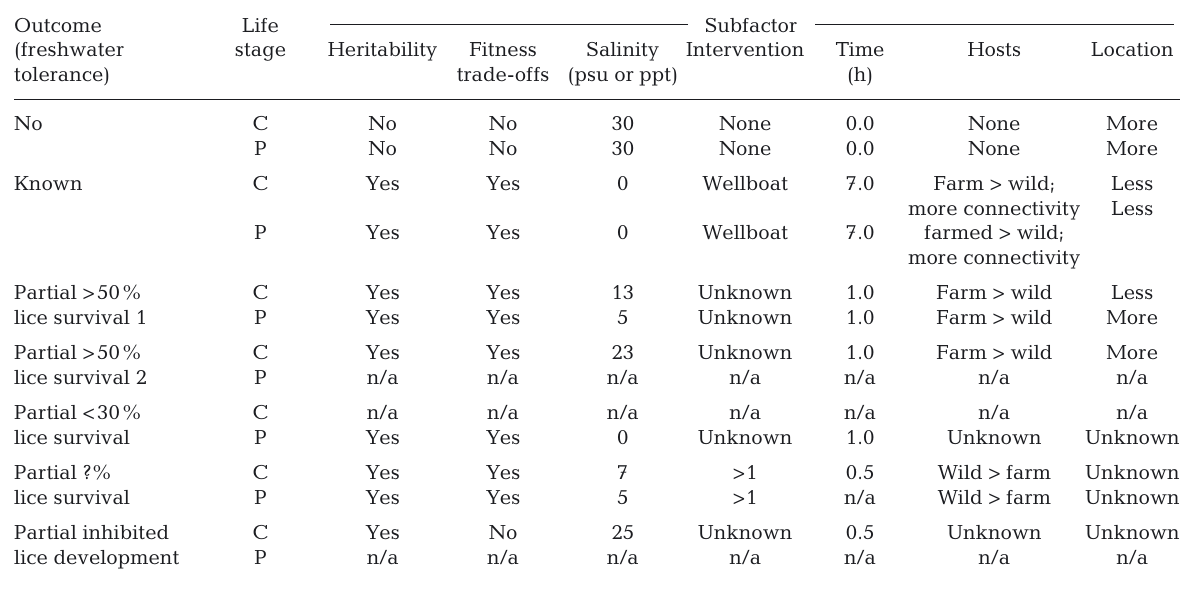
Table 3. Subfactor values for each of our suggested outcomes (degrees of freshwater tolerance evolution). We used 2 example life-stage models in Visual PROMETHEE (C: copepodid; P: preadult). n/a: not applicable. Hosts: type of hosts (farm or